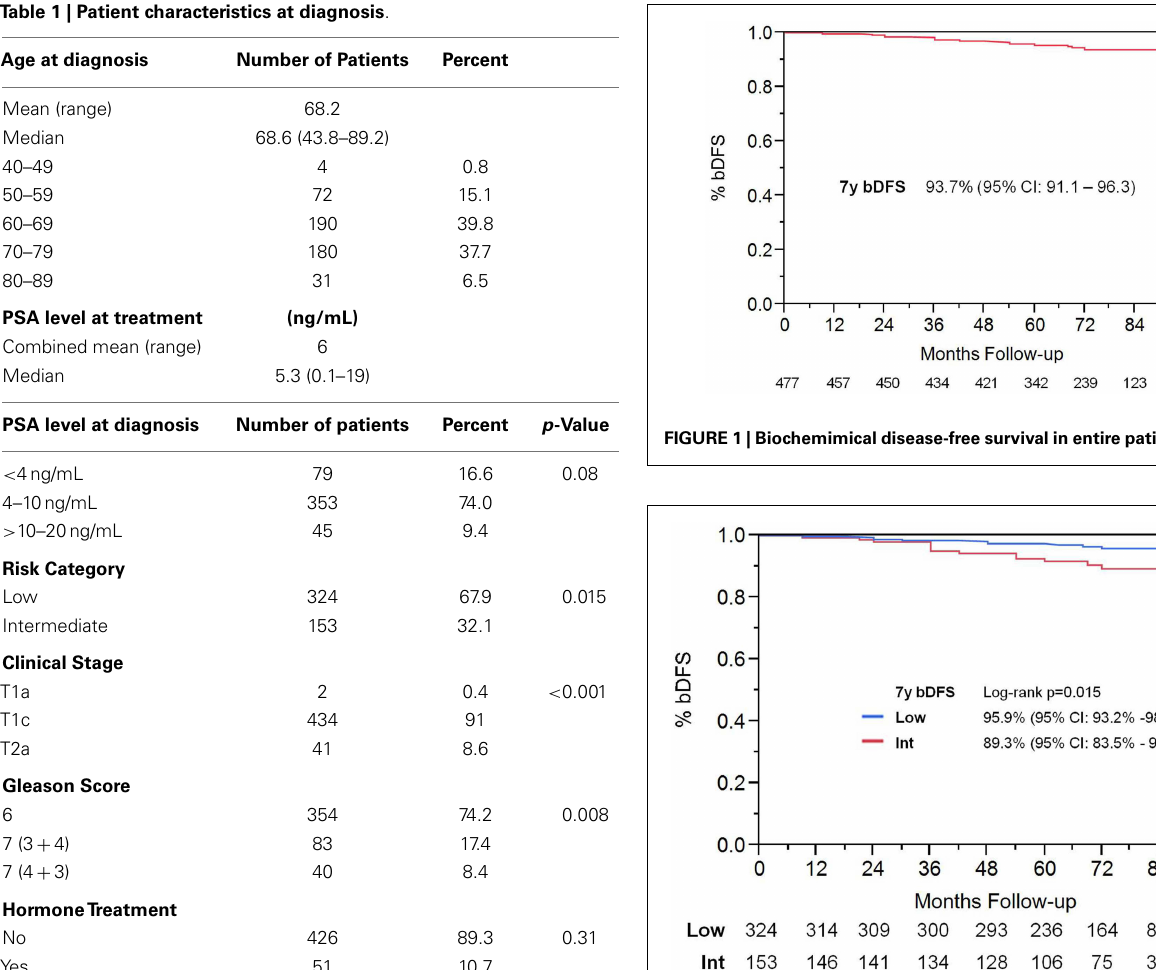
Table 1 | Patient characteristics at diagnosis .